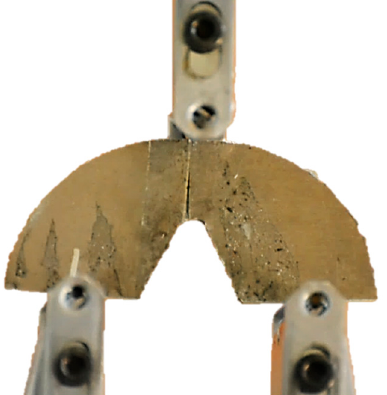
Figure 3. SCB notched sample under pure mode I fracture test.